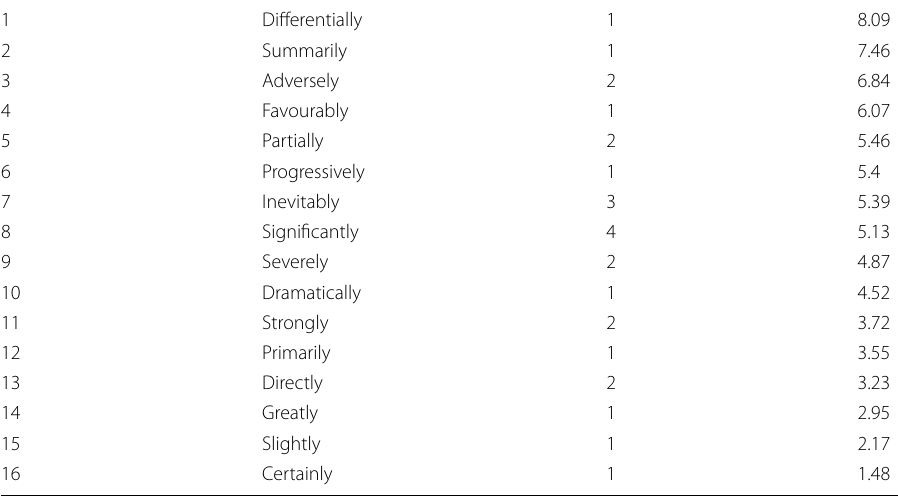
Table 6 Adverbial collocates of impact